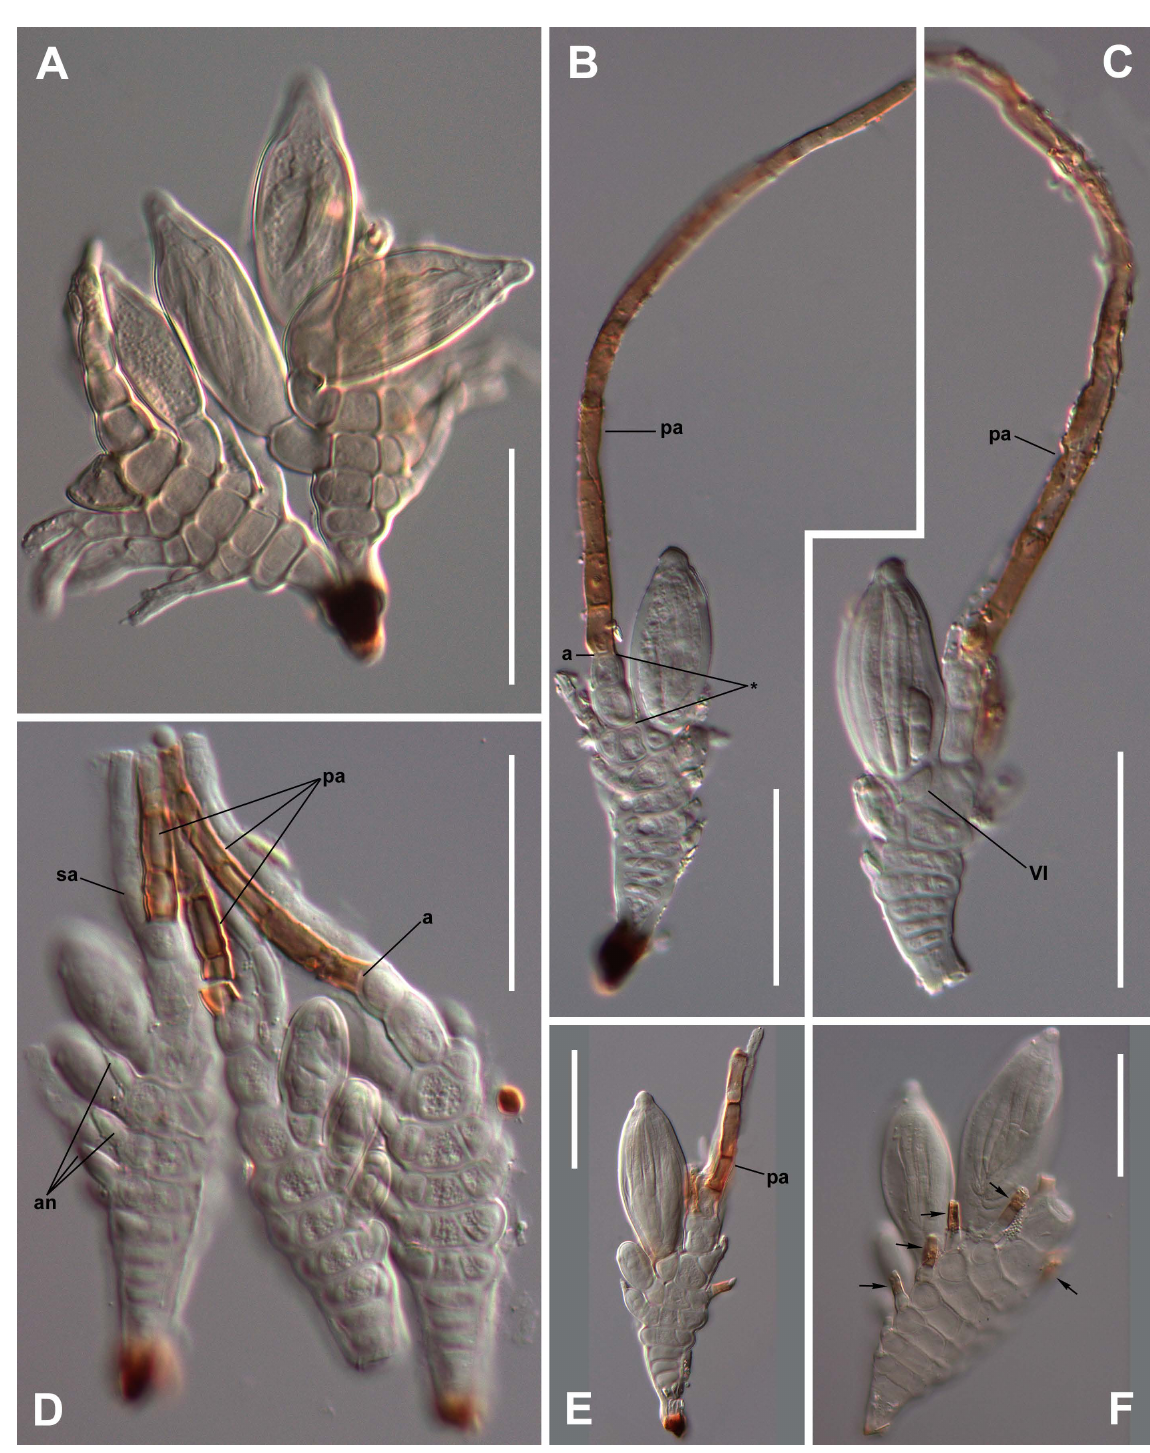
Fig. 8. Euphoriomyces spp. A . E. agathidii (Maire) I.I.Tav. Paired mature thalli. – B – F . E. enghoffii Santam. sp. nov. B . The peduncle of primary appendage is labelled (*). F . Brown basis of appendages are pointed with arrows. Abbreviations: a = primary septum; a = antheridia; pa = primary appendage; sa = secondary appendage; VI = cell VI. Scale bars: 50 µm. Photographs from slides ZMUC C-F-124241 (A), ZMUC C-F-124142 (holotype) (B–C), and ZMUC C-F-124143